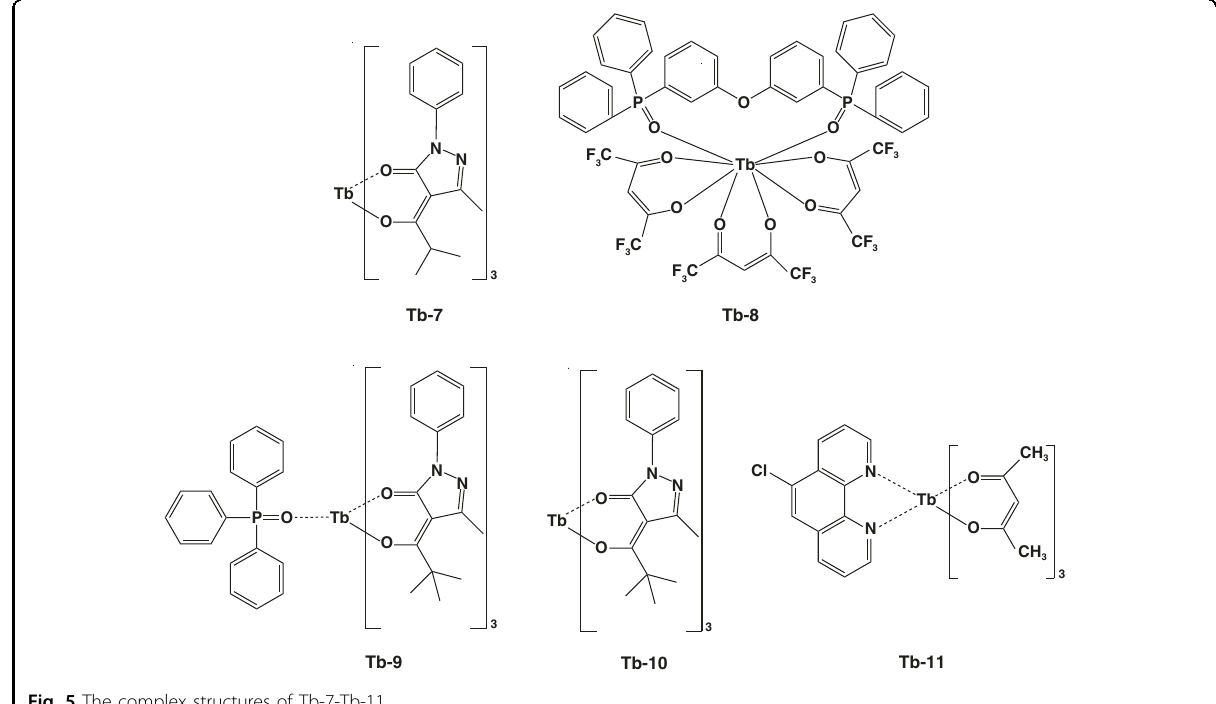
Fig. 5 The complex structures of Tb-7-Tb-11